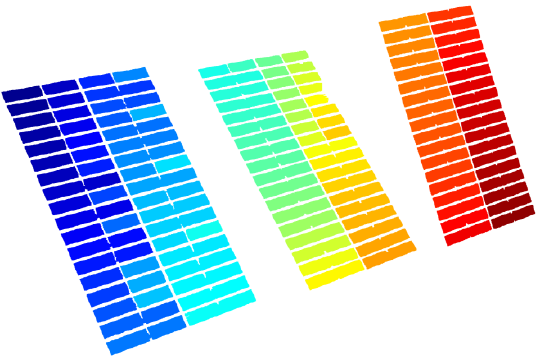
Figure 10. Isolation of the PV panels by image treatment (situation in which there is a vertical fault in the tracker of the right PV module).